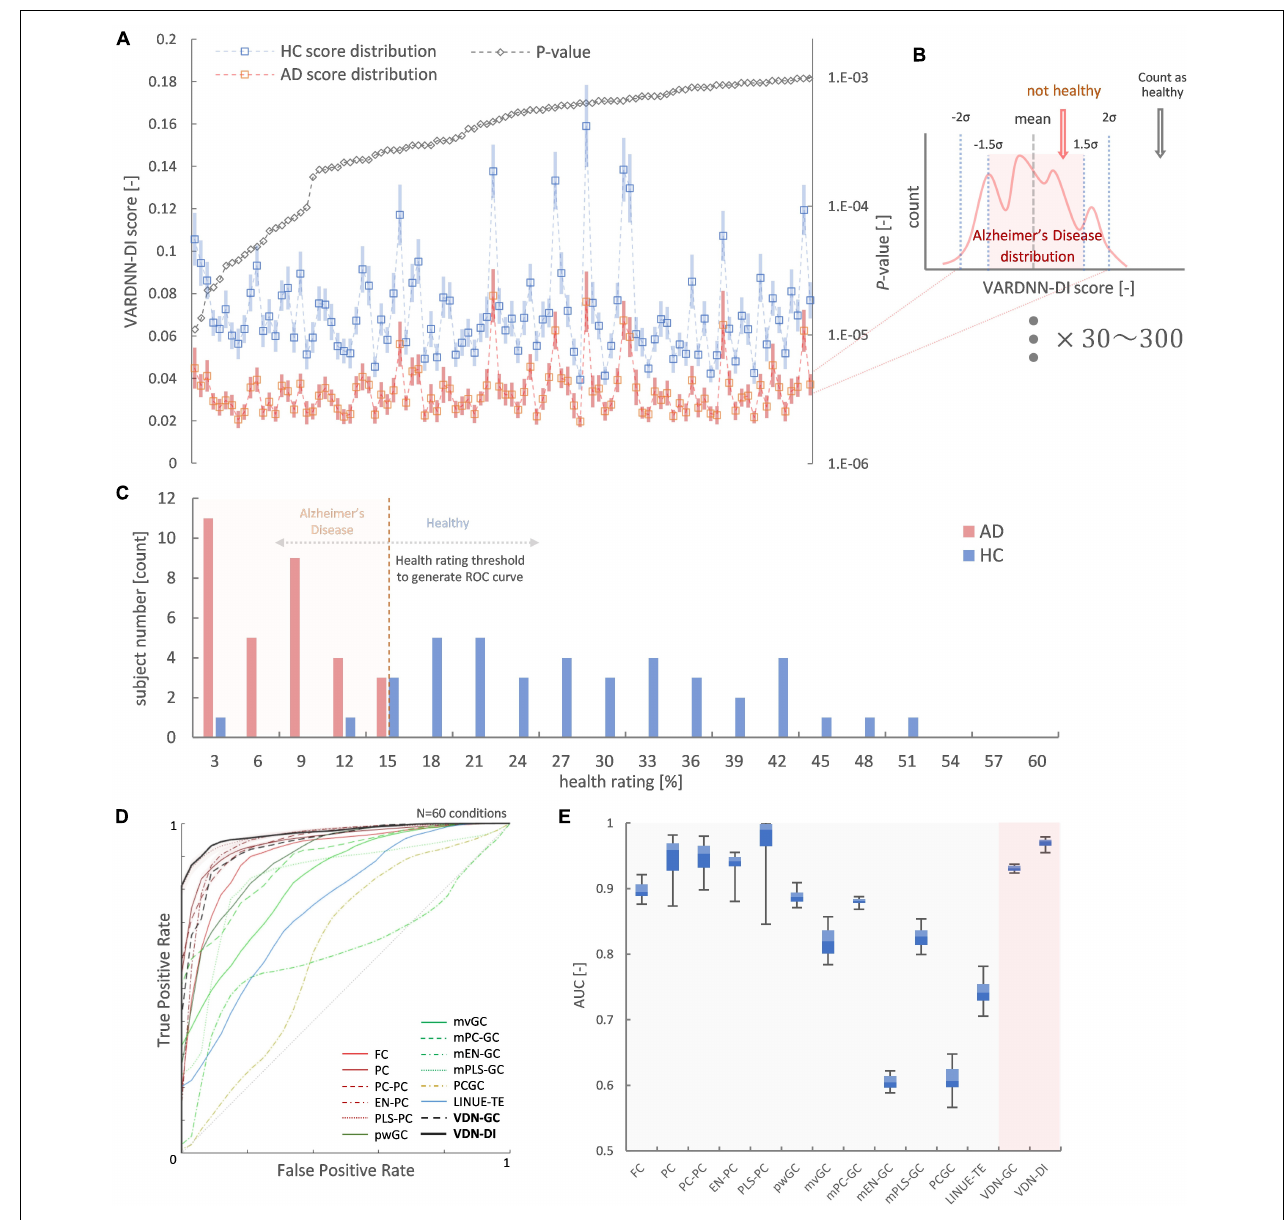
FIGURE 10 | (A) Top 100 most different regional relationships by VARDNN-DI. The left vertical axis shows VARDNN-DI score and blue (HC) and orange (AD) lines show mean score (box) and standard error (bar). The right vertical axis shows the logarithmic scale of p -value. The black dotted line shows the p -value of the regional relationship between AD and HC groups. (B) Healthy count estimation for subject-wise evaluation framework between AD vs. HC. If the input VARDNN-DI score is within the specific σ range (1.5–2.0) of the AD distribution, it is counted as unhealthy. This operation was repeated from top N rr (30–300) most different regional relationships. (C) Example histogram ( N rr = 100, β = 2, VARDNN-DI) of health rating . Red bars show AD subjects. Blue bars show HC subjects. (D) Mean ROC curves of 60 conditions by each analysis algorithm. (E) AUC results from (D)